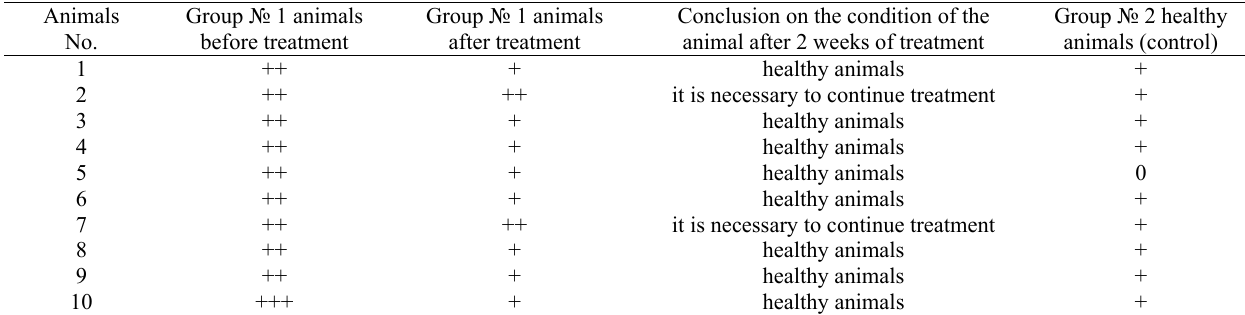
Presence and intensity of endogenous intoxication of the German Shepherd dogs